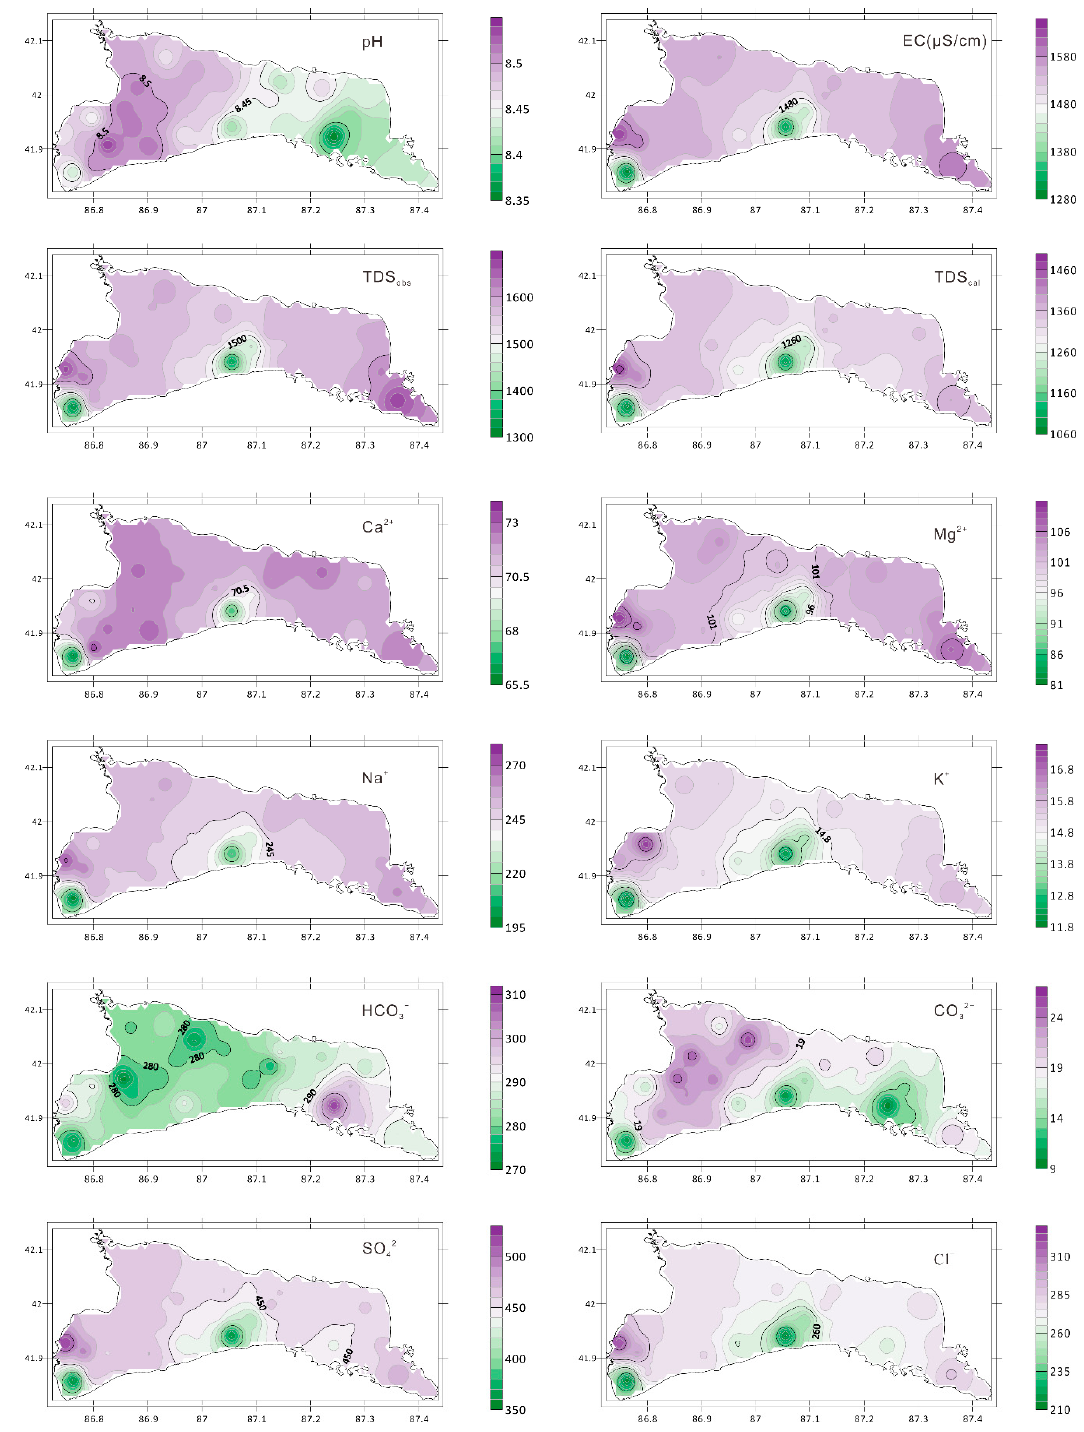
Figure 7. The distribution maps of pH, electrical conductivity (EC), measured value of total dissolved solids (TDS obs ), the calculated value (TDS cal ), and major ions in Bosten Lake water.